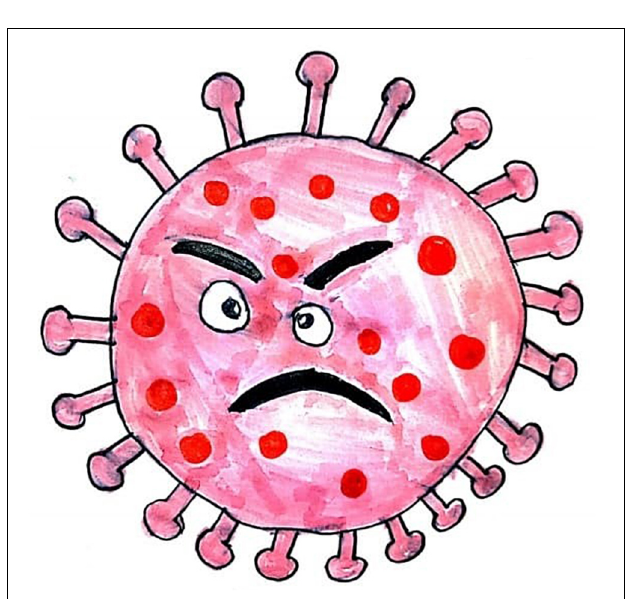
FIGURE 3 | An 11-year-old girl’s partially adequate drawing of SARS-CoV-2 with anthropomorphic features.